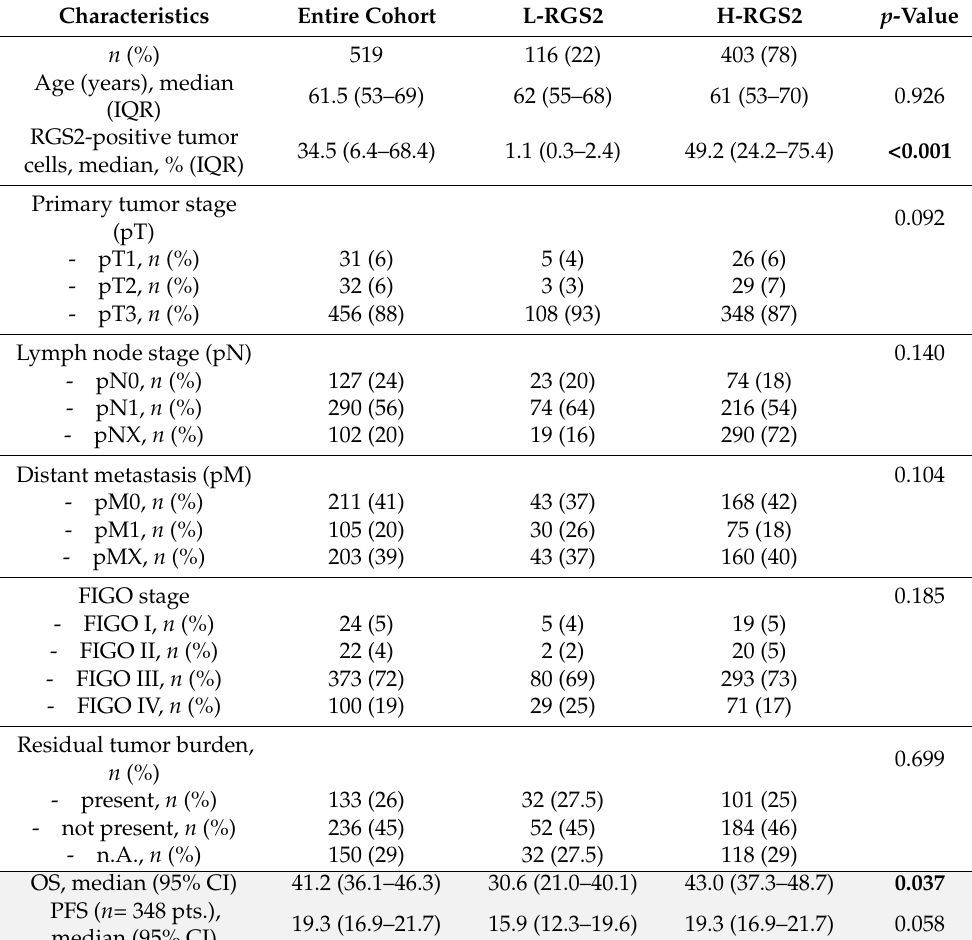
Table 1. Clinical characteristics and univariate survival in the HGSOC cohort with regard to RGS2 protein